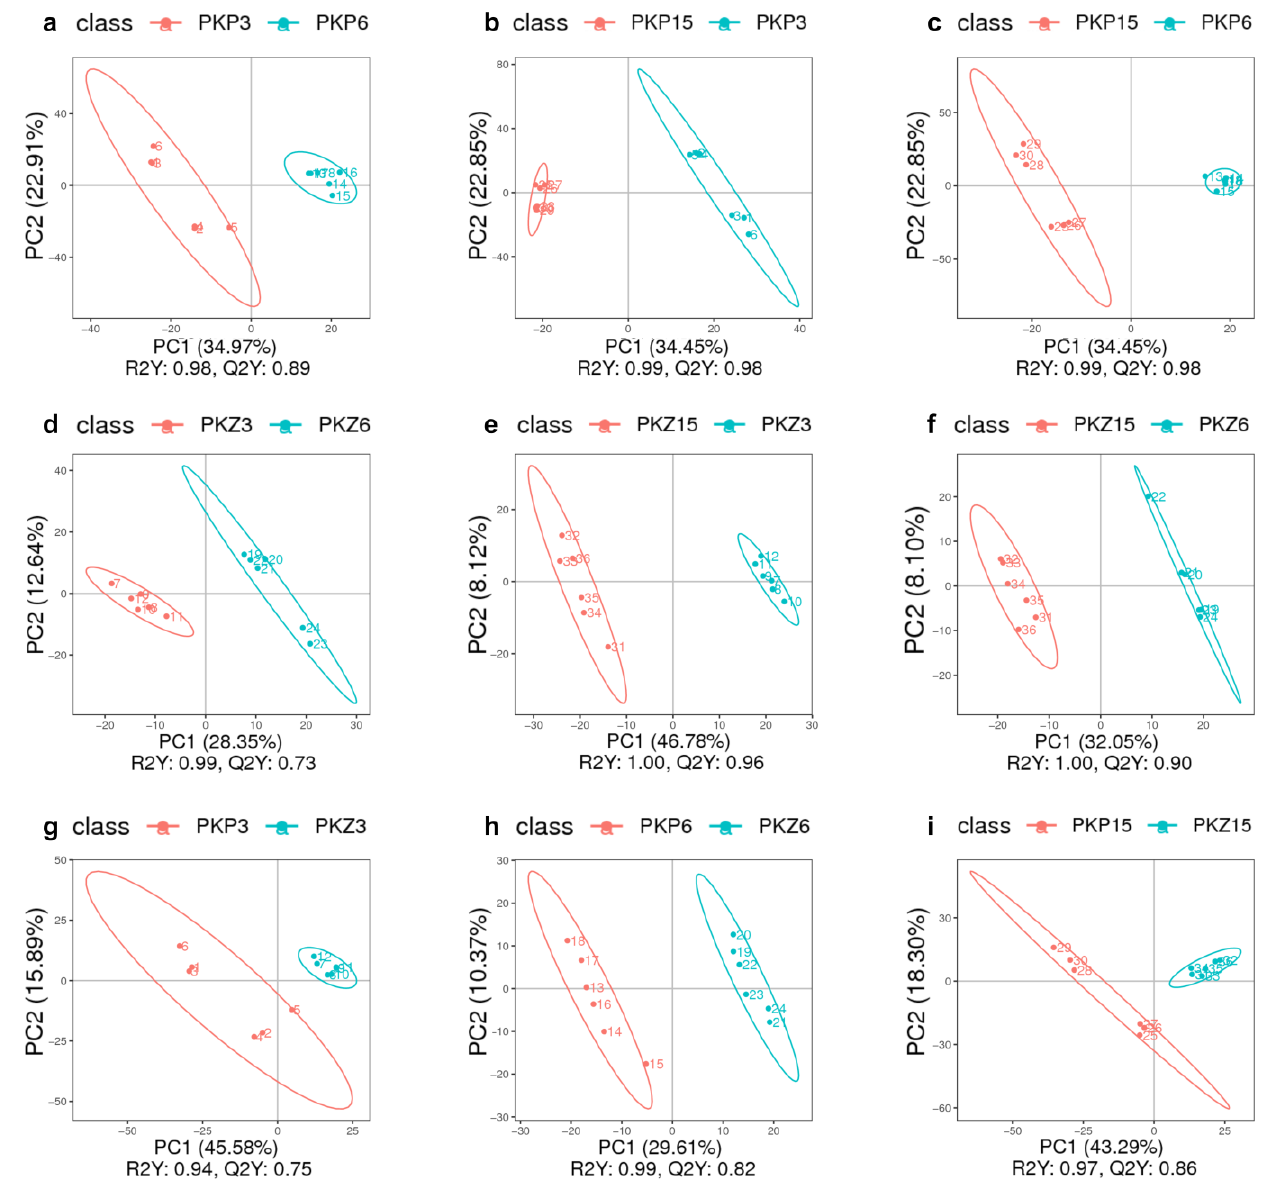
Figure 3. PLS-DA score plot of positive and negative ion modes for each comparison group (positive ion mode). PKP3-PKZ15 is the same as Table 1. ( a ): PLS-DA score plot between PKP3 and PKP6; ( b ): PLS-DA score plot between PKP3 and PKP15; ( c ): PLS-DA score plot between PKP6 and PKP15; ( d ): PLS-DA score plot between PKZ3 and PKZ6; ( e ): PLS-DA score plot between PKZ3 and PKZ15; ( f ): PLS-DA score plot between PKZ6 and PKZ15; ( g ): PLS-DA score plot between PKP3 and PKZ3; ( h ): PLS-DA score plot between PKP6 and PKZ6; ( i ): PLS-DA score plot between PKP15 and PKZ15.